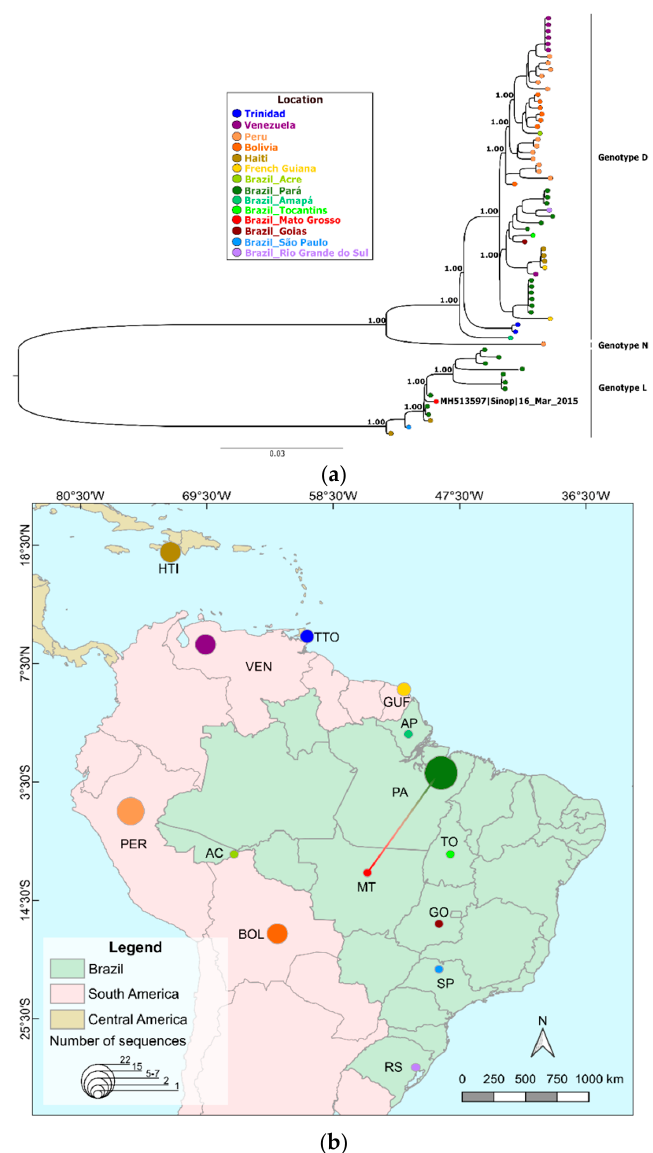
Figure 2. Full phylogenetic reconstruction of MAYV. ( a ) Phylogeny including all available MAYV genomes and positioning of MAYV genome obtained in this study using maximum likelihood of complete and draft genomes (>8 kb) available. ( b ) Distribution of the number of MAYV genomes sequenced per country and Brazilian state and colored edges showing a possible route of MAYV spread based on the most closely related MAYV genome from the phylogenetic analysis shown in panel A. Country and Brazilian state colors follow tip colors in panel A.